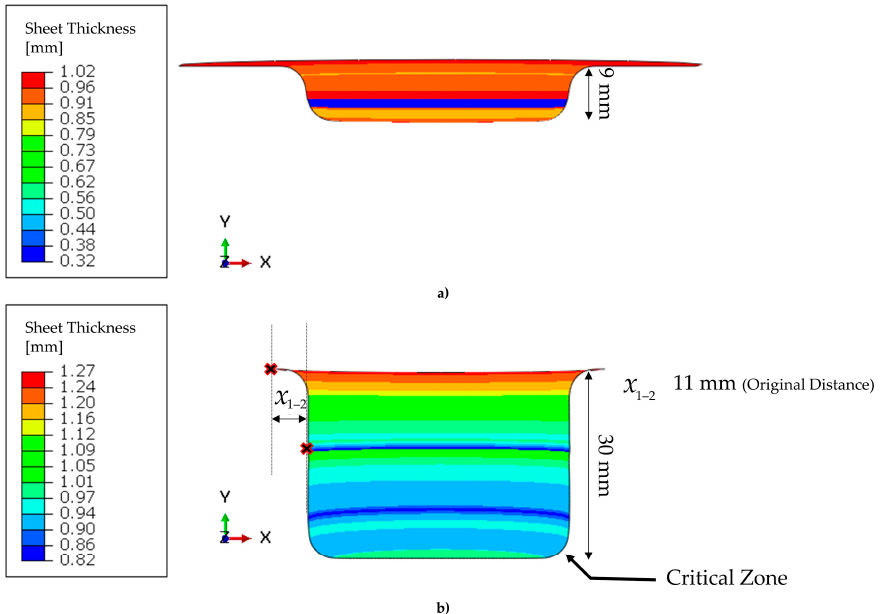
Figure 11. Final sheet thickness distribution along the cup’s wall for ( a ) the base material model and ( b ) the heat treated model. HAZ = 11 mm and ∆ UTS = 29%.